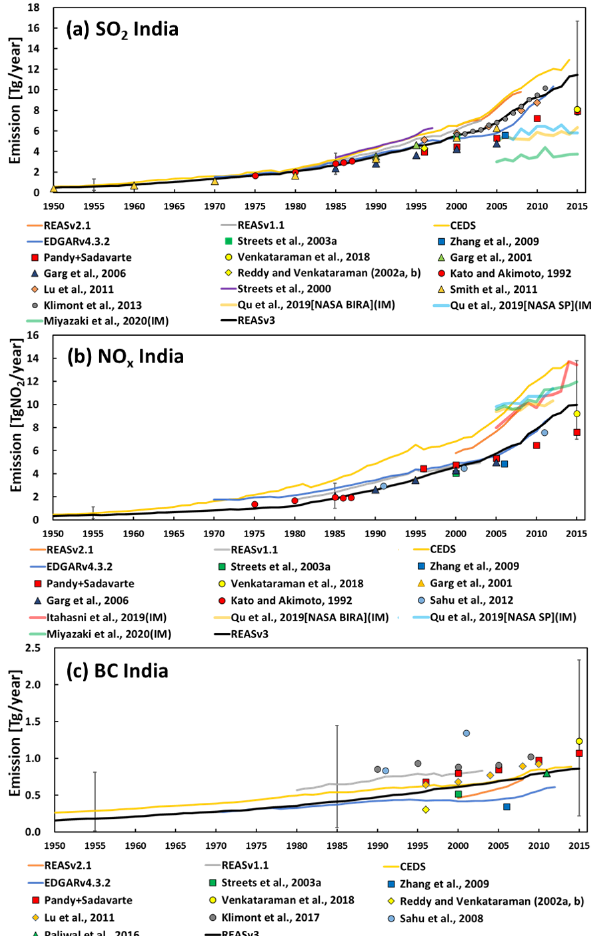
Figure 11. Comparison of (a) SO 2 , (b) NO x , and (c) BC emis- sions in India between REASv3 and other studies. Note that val- ues of “Pandy+Sadavarte” are calculated from Pandey et al. (2014) and Sadavarte and Venkataraman (2014). Emissions from domes- tic and fishing ships were excluded from REAS series, CEDS, EDGARv4.3.2, Garg et al. (2006) and Paliwai et al. (2016). IM means estimates by inverse modeling. Error bars indicate the un- certainty range of REASv3 in 1955, 1985, and